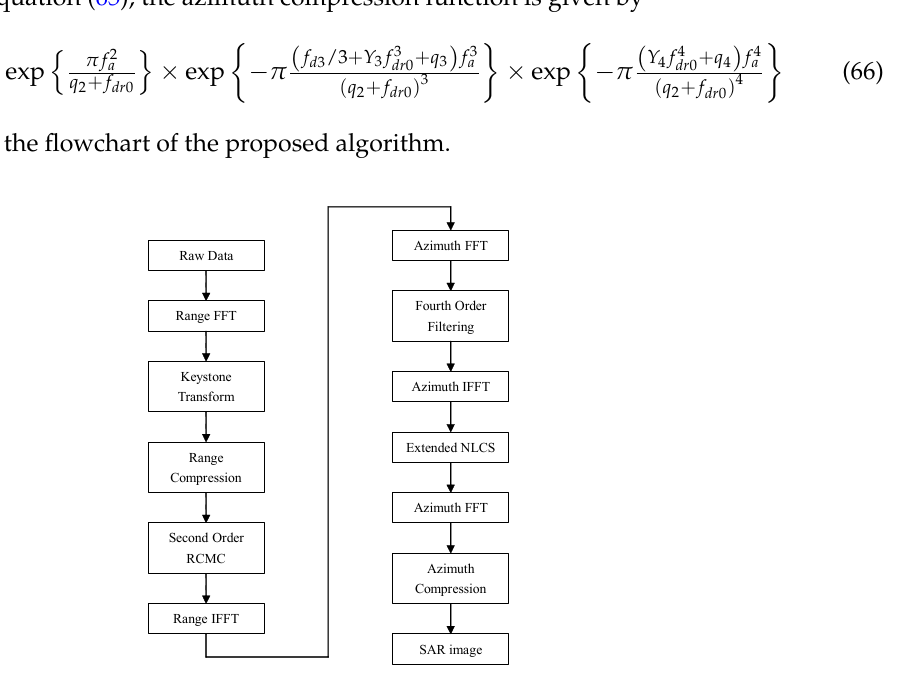
Figure 4. Flowchart of the proposed algorithm. FFT: fast Fourier transform; RCMC: range cell migration